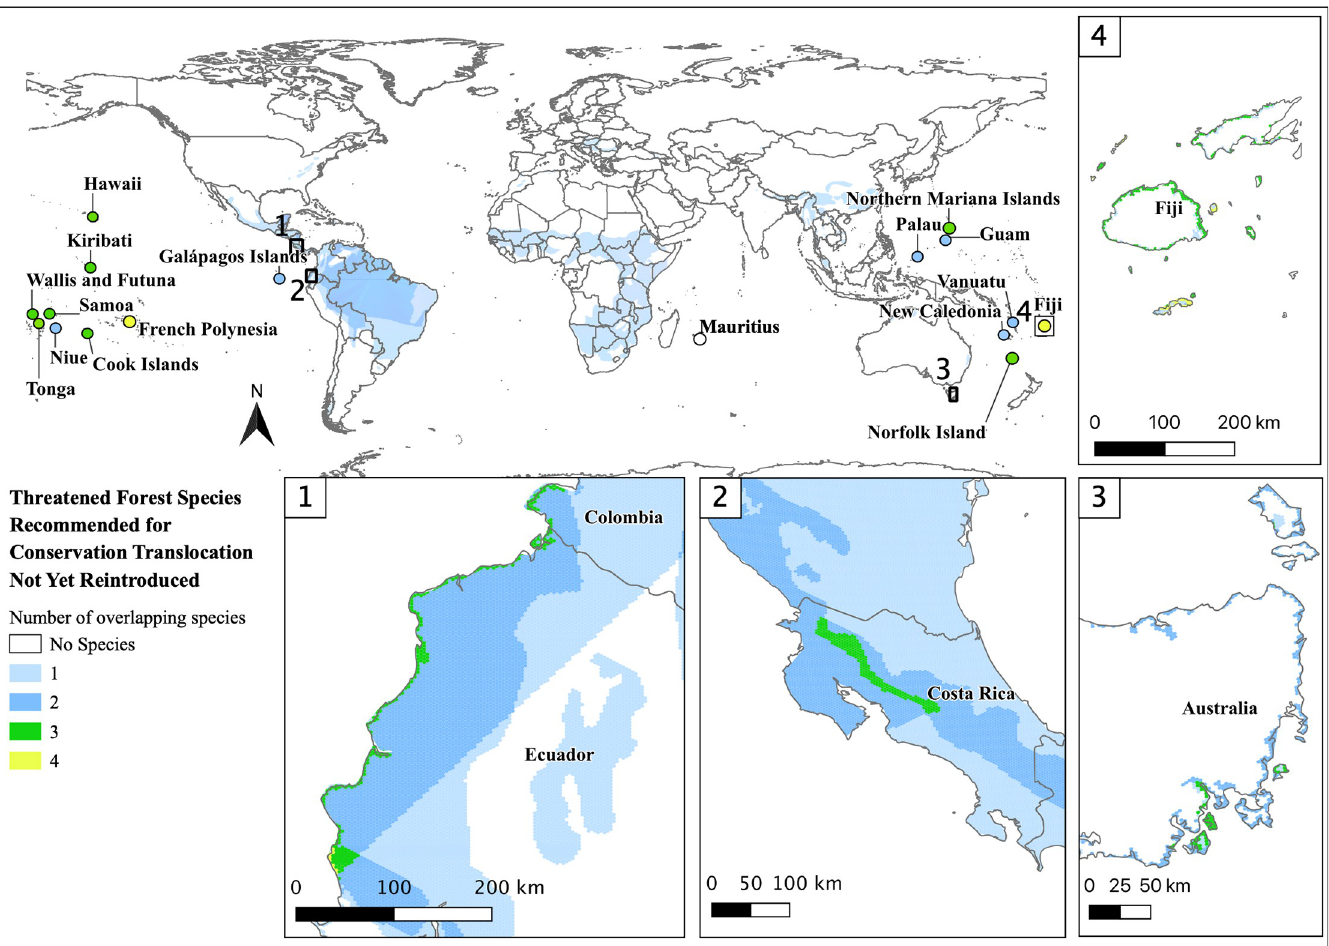
Fig 4. Overlapping species range maps for 68 threatened and Near Threatened terrestrial species, amphibians, birds, mammals, that live in forest habitat without a CT program in-place. Reprinted partially from the Environmental Systems Research Institute (ESRI) under a CC BY license, with permission from ESRI, original copyright